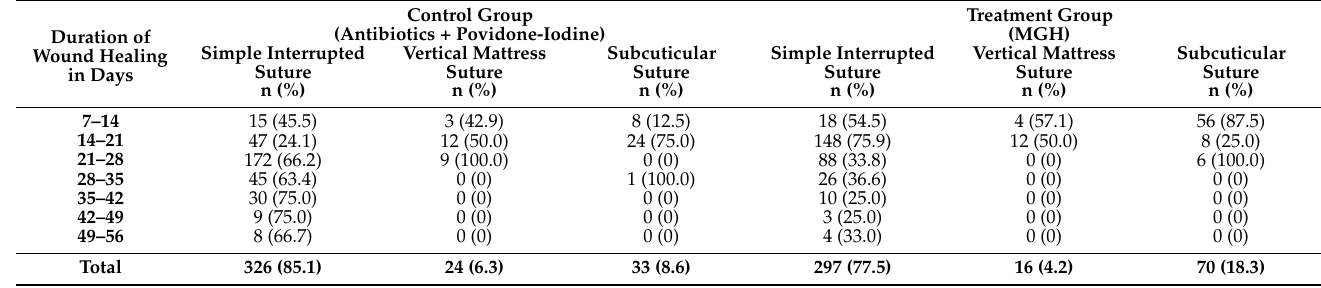
Table 8. Overview of wound healing time per suture technique (simple interrupted, vertical mattress, and subcuticular). The percentages represent the distribution over the two study groups for the specific suture technique.